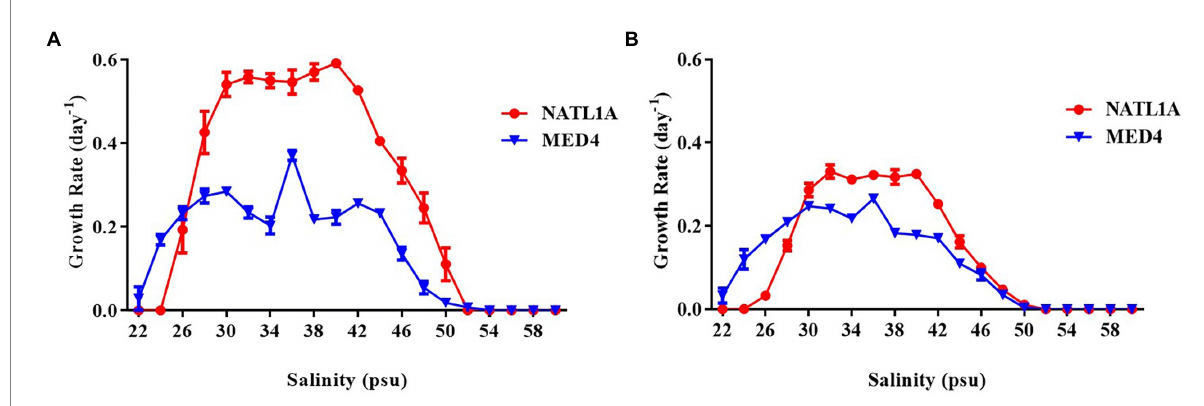
FIGURE 1 Growth rate of Prochlorococcus strains NATL1A and MED4 growing in Pro99 medium with salinities from 22 psu to 60 psu. Flow cytometry (A) and absorbance (OD440) measurement of chlorophyll (B) were used to monitor